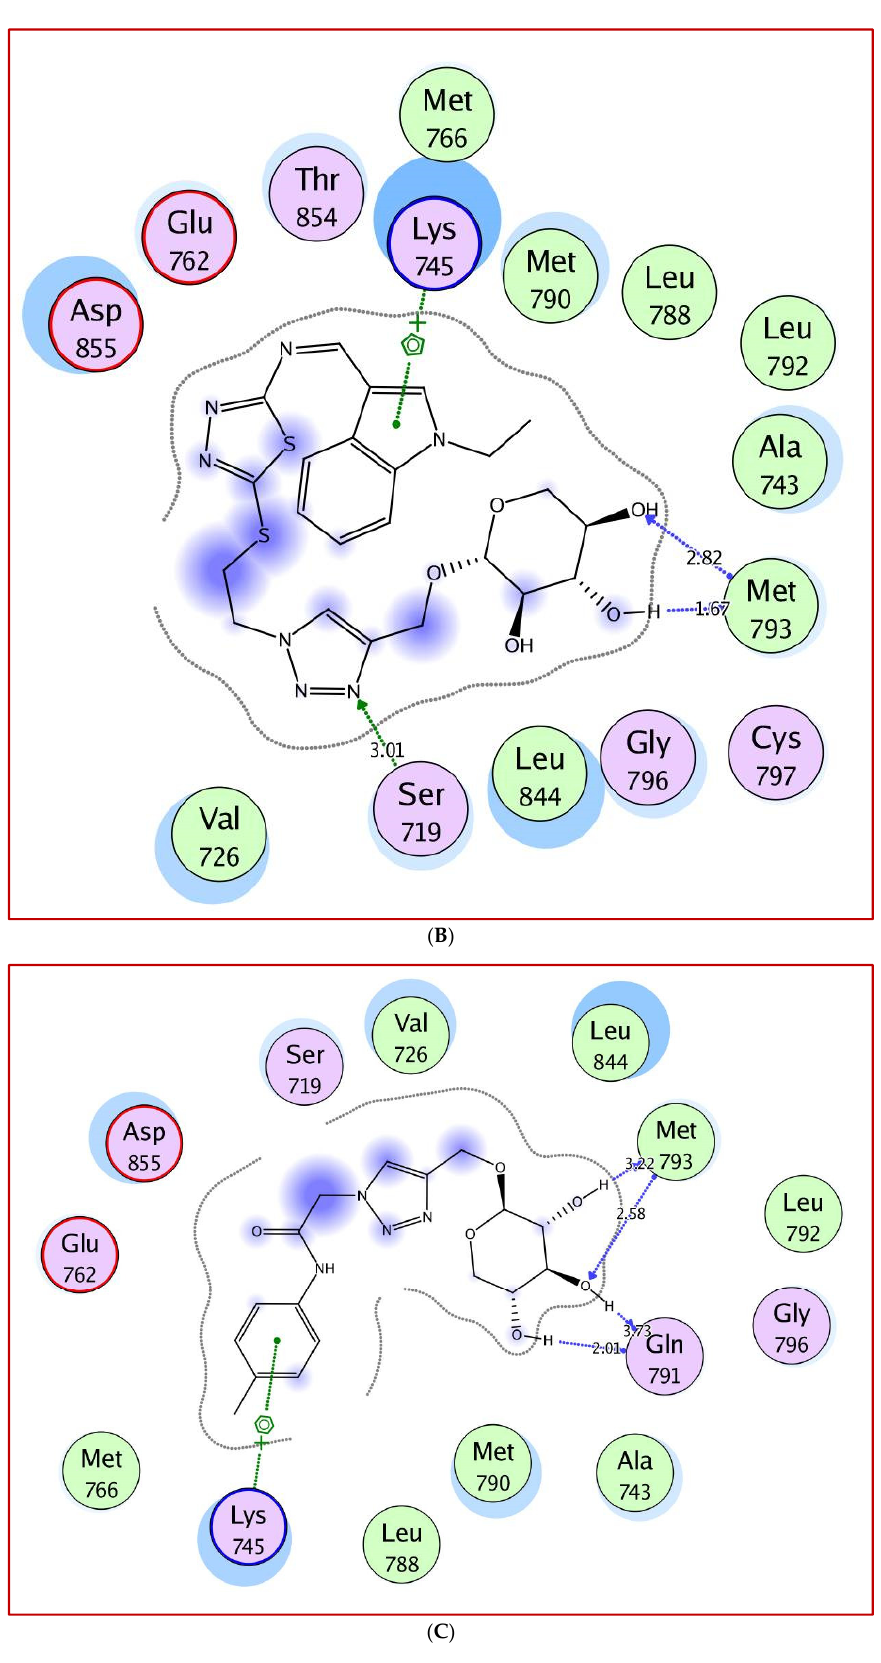
Figure 5. ( A – C ) Two-dimensional views of compounds 7 , 8 and 15 , respectively, docked in the active binding site of EGFR T790M (PDB ID: 3UG2) using MOE software. By focusing on Figure 6, it can be noted that 15 has an improved fit within the active site of HER-2 through an additional arene–arene interaction between the p-tolyl moiety and the essential amino acid Phe864 .